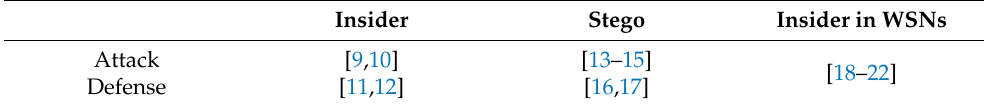
Table 1. Structure of the overview of related